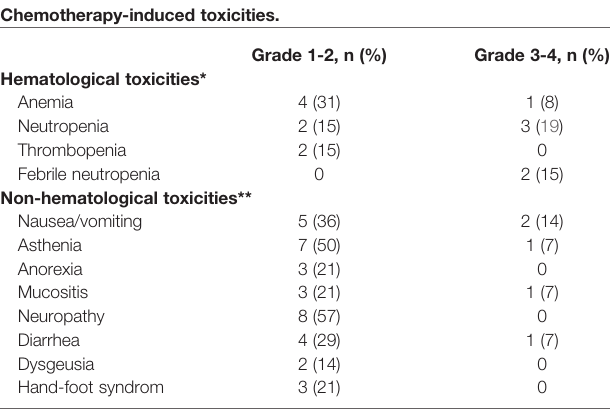
*Calculated for 13 patients (missing data for three patients). **Calculated for 14 patients (missing data for two patients). Data n (%) are indicated for which a patient could have more than one adverse event.